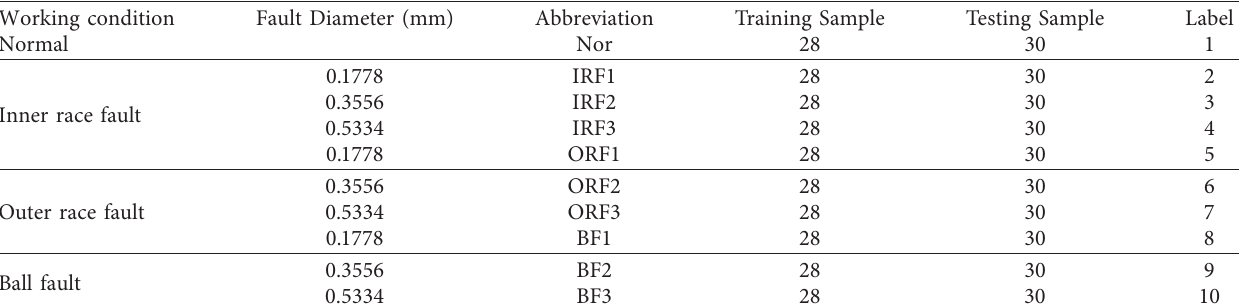
Figure 9 is the evolution curve of fitness value in the op-